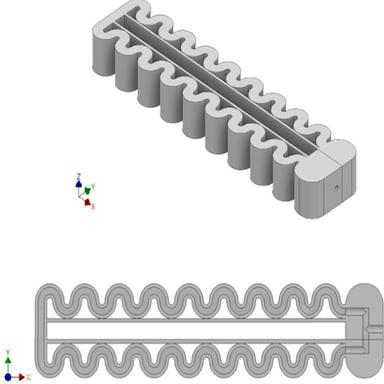
Close dual bellow pneumatic actuator CAD model.